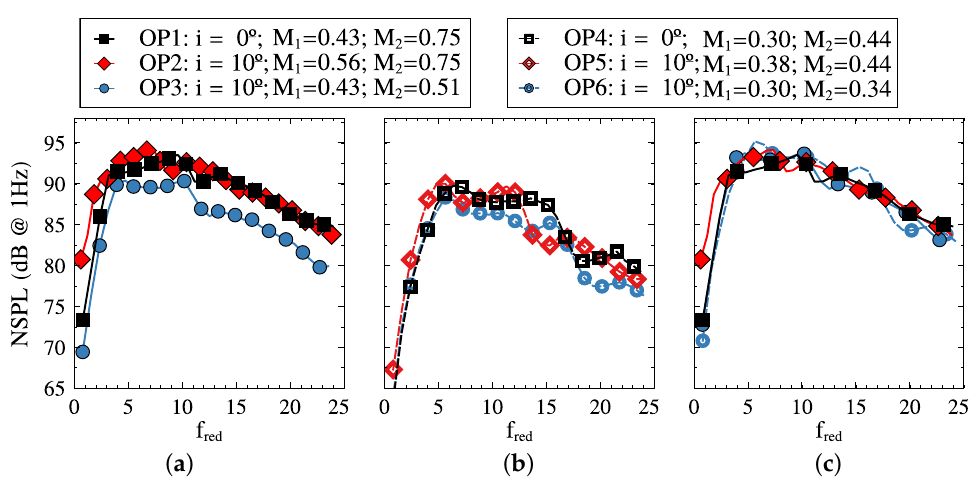
Figure 13. Outlet NSPL for operating points 1–6. ( a , b ) compare, respectively, the results of OP1-3 and OP4-6. ( c ) shows the NSPL of OP1-3 and 6 scaled with the outlet Mach number squared, M 2